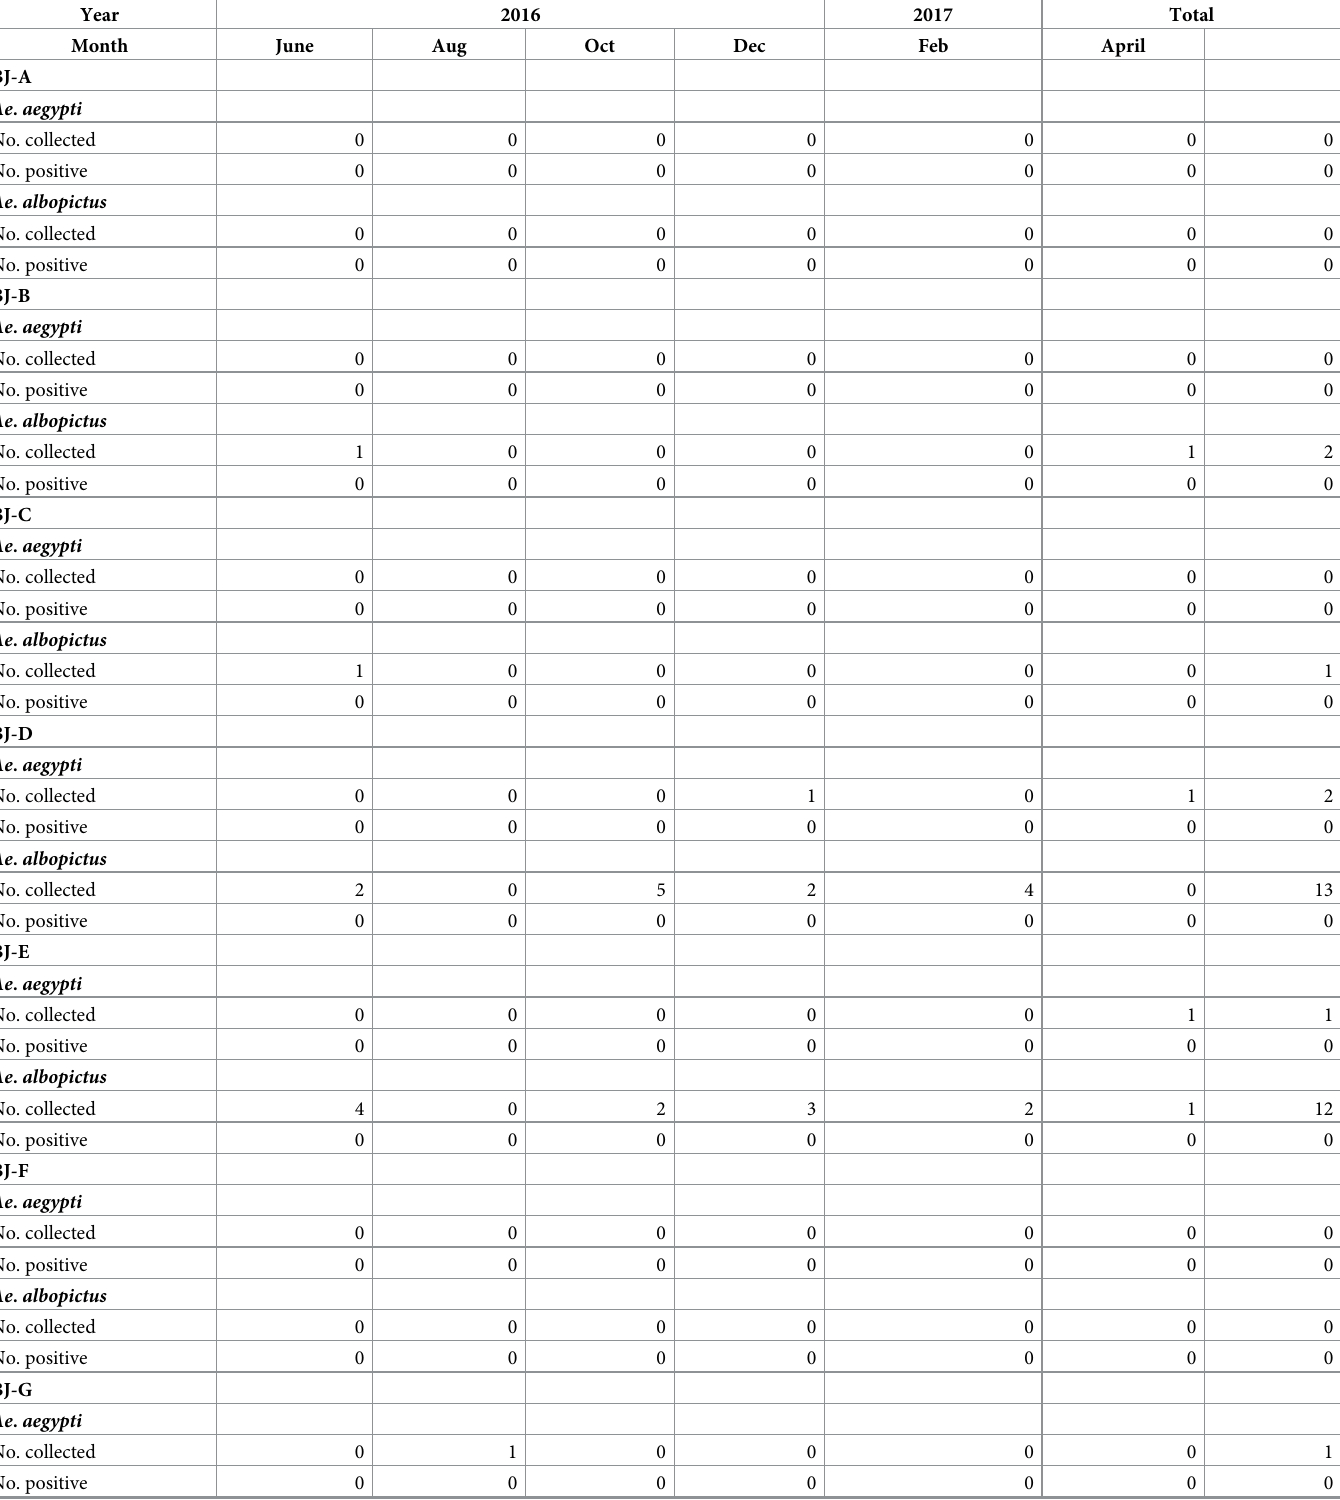
Table 5. DENV detected in adult Aedes mosquitoes collected in Kuala Lumpur from June 2016 to April